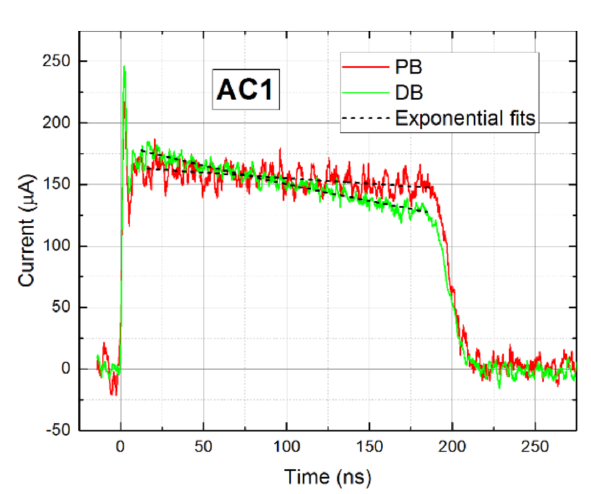
Figure 10. Current waveforms of sample AC1 at 50 V measured at PB and DB after 1 min of biasing. Fits of Current waveforms (CWFs) are shown as